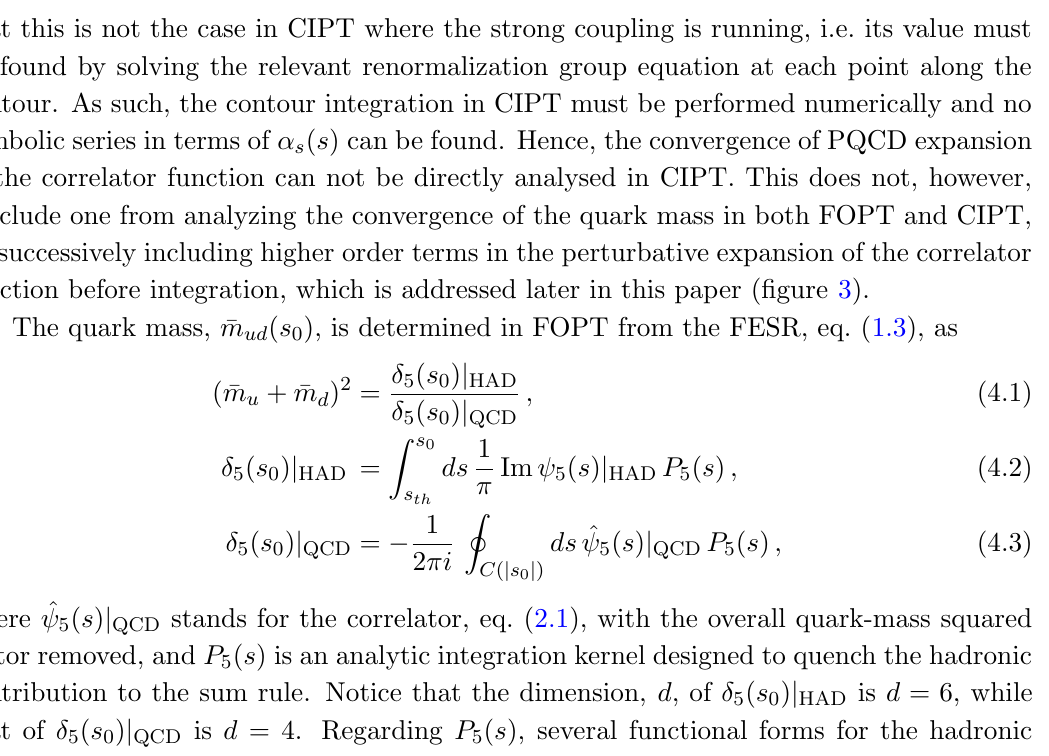
Figure 2 . Hadronic spectral function in the resonance region, eqs. (3.7){(3.8) with (cid:20) = 0 : 1, and involving two radial excitations of the pion, (cid:25) (1300) and (cid:25)